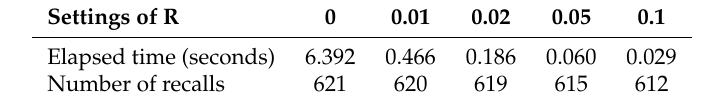
Table 2. An example of the influence of R in Algorithm 1 to the Elapsed time and the number of recalls. Settings of R 0 0.01 0.02 0.05 0.1